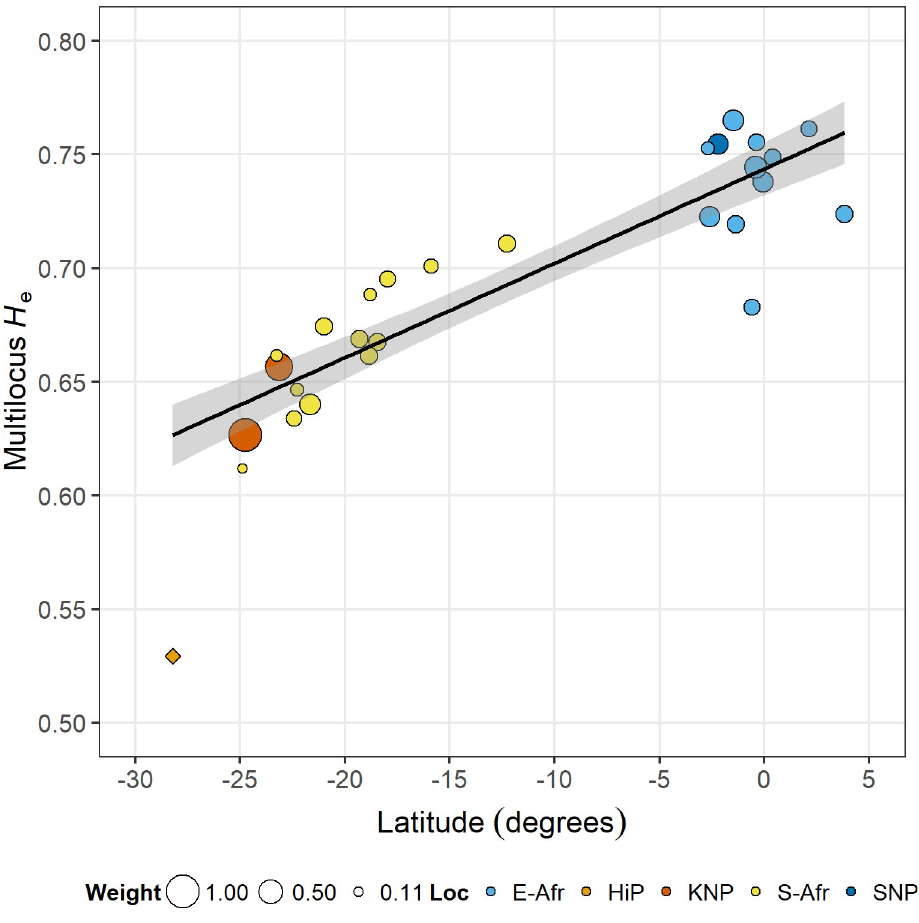
Fig 3. Multilocus- H e